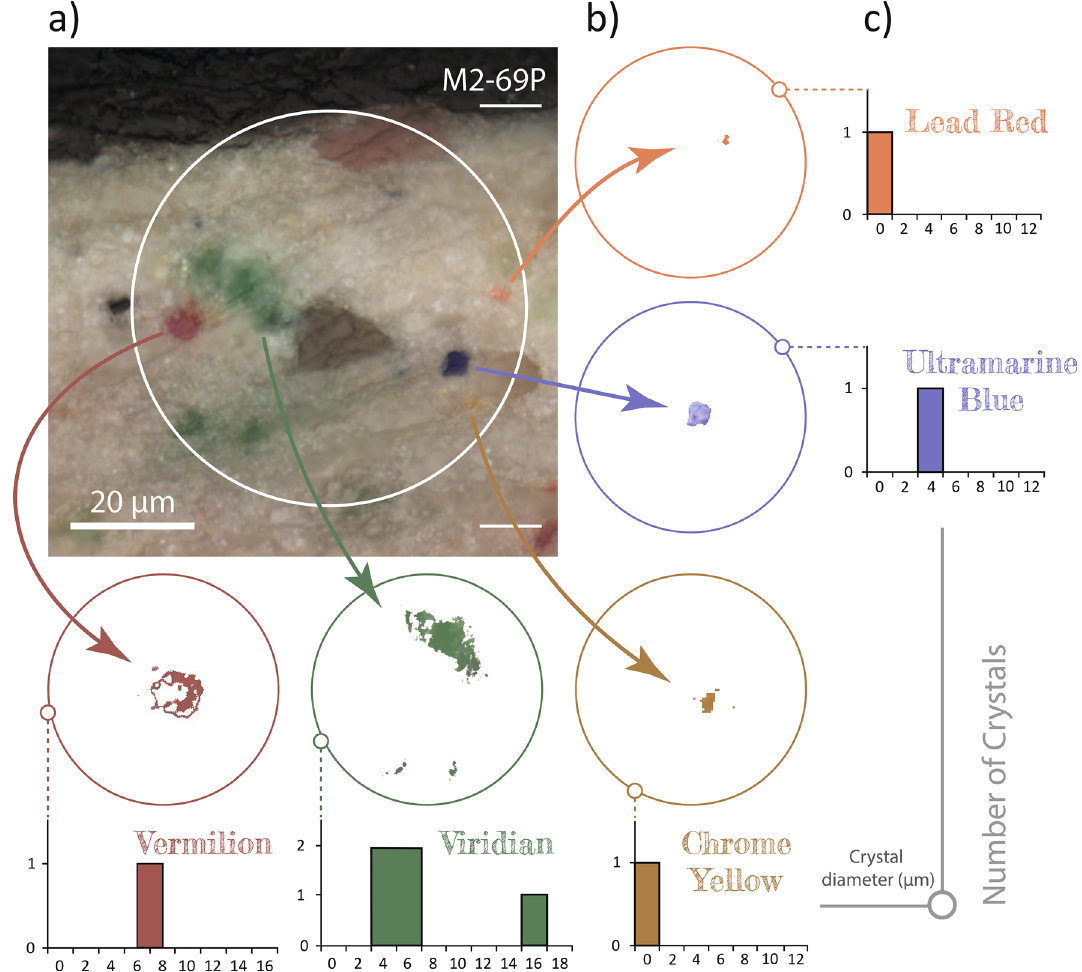
Figure 5. Between particles: measuring crystals with CrystalDistribution software. ( a ) The user opens a microscope image and select the region containing crystals of interest. ( b ) The program applies masks or “cuts” identifying the crystals and saves the images. Each image shows the crystals of a specific colour. ( c ) The program calculates the crystals’ area and diameter, and generates a histogram for each